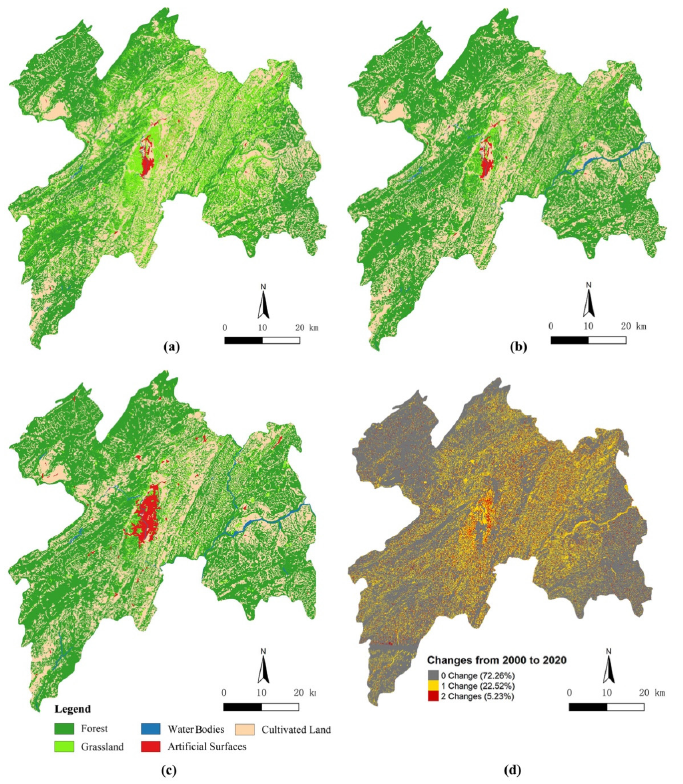
Figure 3. Land use in Enshi City. ( a ) Land use in Enshi City in 2000; ( b ) Land use in Enshi City in 2010; ( c ) Land use in Enshi City in 2020; ( d ) Accumulated changes from 2000 to 2020.